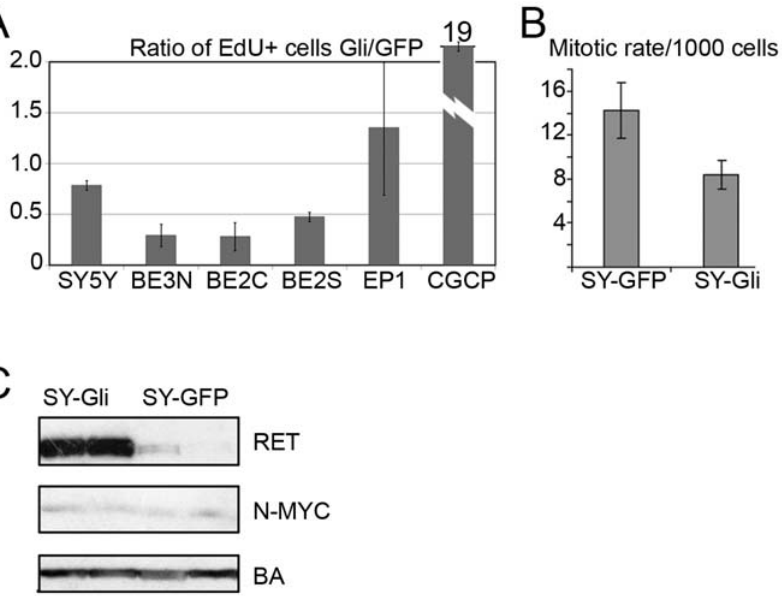
Figure 3. Gli1 slowed proliferation of NB cell lines while driving CGNPs to proliferate. A) Transduction of Gli1 decreased proliferation of NB cell lines SY5Y, BE2(N), BE2(C) and BE2(S). Proliferation in SH-EP1 was relatively unaffected (P . 0.05) while proliferation of CGCPs was increased 19- fold. Error bars represent standard deviation normalized mean. B) Decreased proliferation of SY-Gli cells relative to SY-GFP was confirmed by measuring the mitotic rate of both lines, expressed as PH3 + cells per 1000. Error bars represent standard deviation. C) Western blot of two independent SY-Gli and SY-GFP cultures demonstrated the N-MYC expression was not affected by Gli1 transduction, while RET was strongly induced by Gli1.